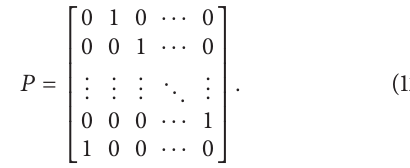
Figure 5: Two subimage windows, their pixels have the same spatial locations; (a) is a previous band and (b) is a current